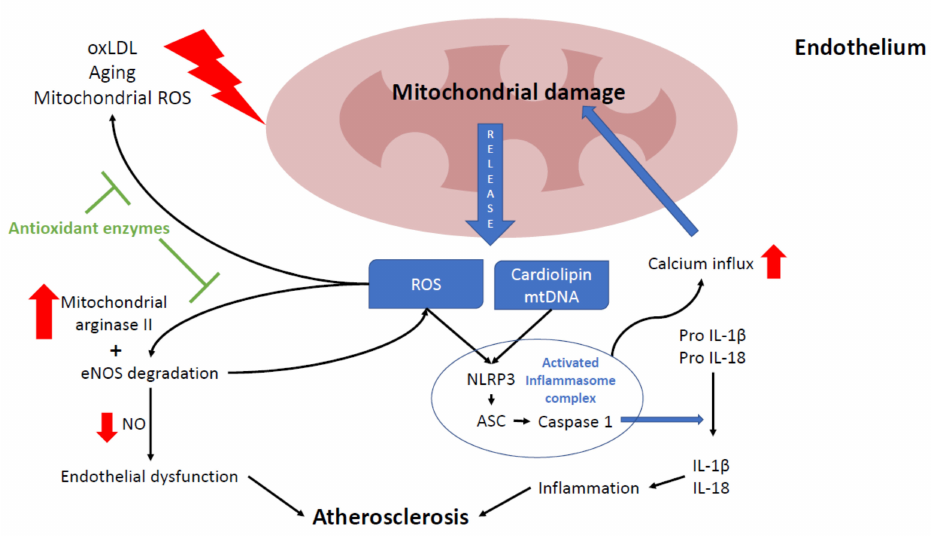
Figure 2. Relationship between mitochondria and atherosclerosis in the endothelium. Mitochondria play a key role in endothelium function, participating in several processes, such as nitric acid production, intracellular signaling, and cell death. Excessive reactive oxygen species (ROS) production leads to endothelium senescence, apoptosis, and atherosclerosis progression. Mitochondria can be damaged by oxLDL, ROS (mostly from mitochondrial origin), and the aging process. Damaged mitochondria release several mitochondrial components such as mtROS, cardiolipin and mtDNA which induce nod like receptor family pyrin domain containing 3 (NLRP3) inflammasome activation, leading to inflammation by increasing interleukin 1 β and 18 maturation. Chronic NLRP3 activation will eventually lead to more mitochondrial damage by promoting mitochondrial calcium influx. Also, higher ROS levels disrupt the NO balance by boosting mitochondrial arginase II activity and causing eNOS degradation. In endothelium, the reduction of NO levels may also promote endothelial dysfunction and atherosclerosis. Most of these ROS-derived alterations are prevented by antioxidants enzymes (green block